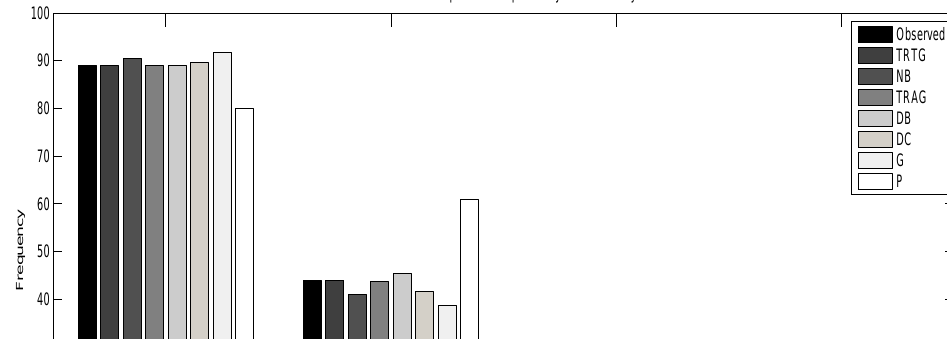
The number of hospitalizations per family member and year